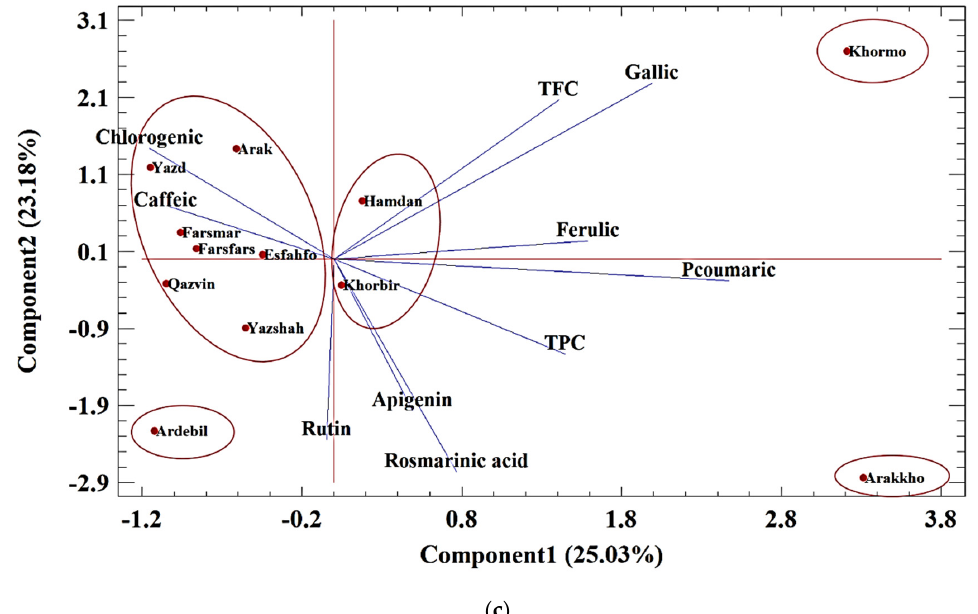
Figure 4. ( a – c ). PCA analysis for classification of 12 ajowan populations based on HPLC compounds in ( a ) normal, ( b ) moderate drought stress, and ( c ) severe stress conditions.